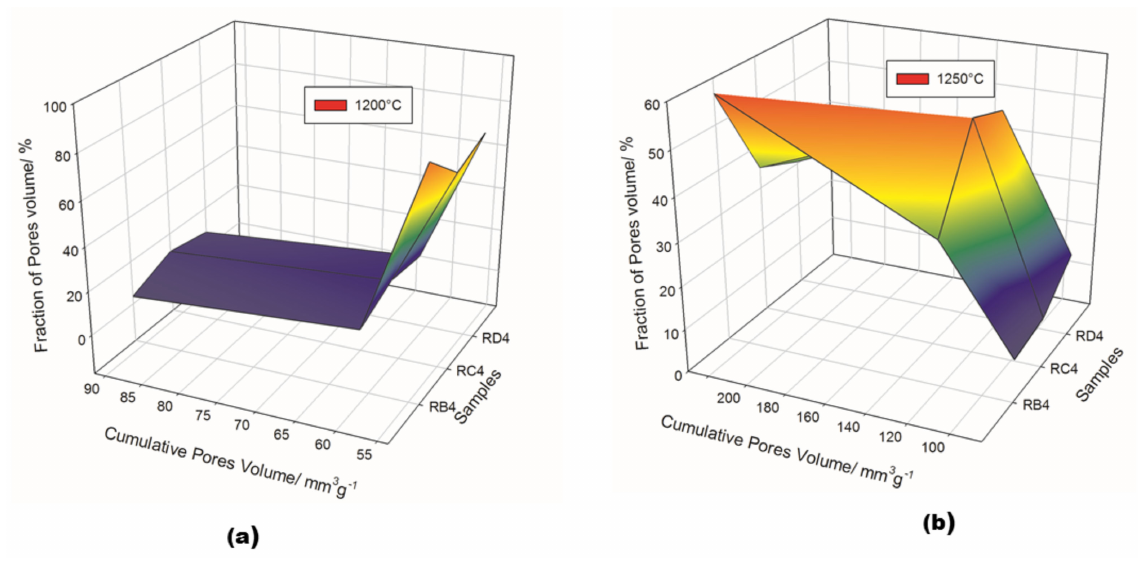
Figure 11. Pore structure of the selected refractory geopolymer matrices. ( a ) 1200 ◦ C, ( b ) 1250 ◦ C. Despite the relative amount of pore volume at 1250 ◦ C (equal to 85.3, 122.3 and 231.0 mm 3 · g − 1 for RB4, RC4 and RD4, respectively), the proportion of macropores still decreased to 56.7, 34.8 and 30.5 mm 3 · g − 1 for the RB4, RC4 and RD4 materials,